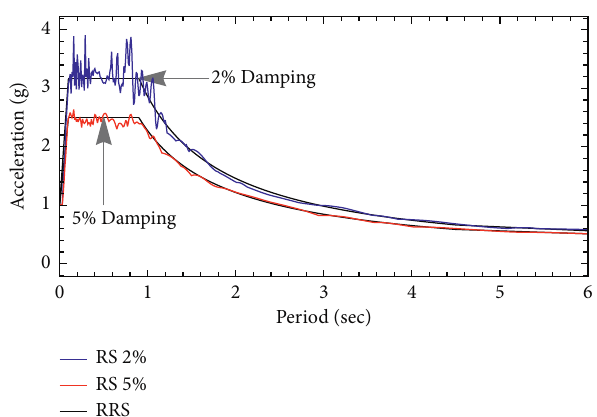
Figure 13: Response spectra of the artificial earthquake and the